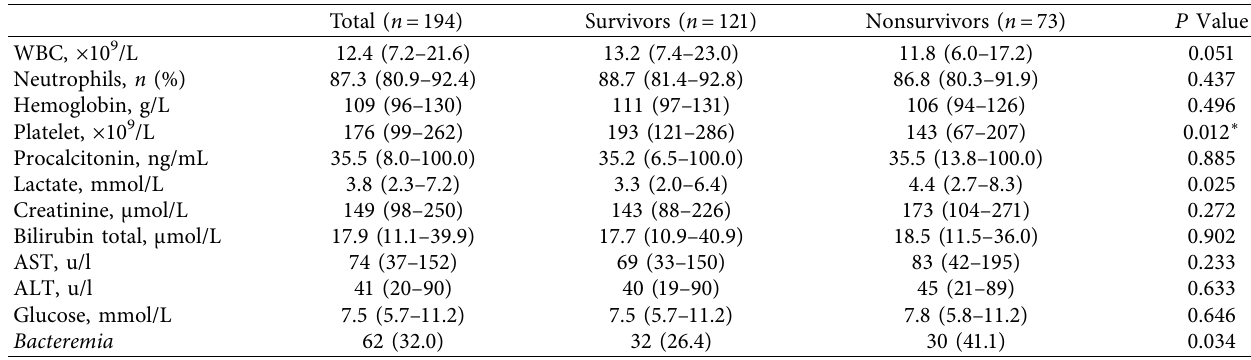
Table 2: Baseline laboratory data at admission.